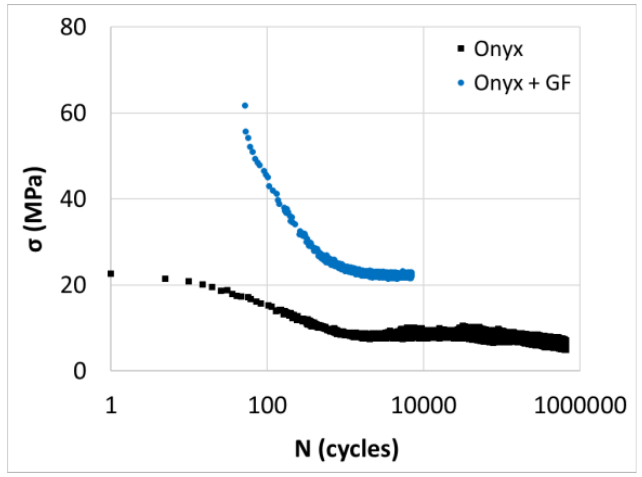
Figure 21. Relative stress (~Young’s modulus) trend within the fatigue test [24]. Variation in the amplitude of the applied loading results in self-heating for CF-PA6 and continuous glass fiber-reinforced CF-PA6 during the fatigue test. This phenomenon affects the viscosity of the polymer as a function of temperature. Figure 22 depicts the temperature rise during the fatigue test concerning the utilized frequency of 10 Hz. It was observed that the induced temperature of CF-PA6 increased up to about 60 ◦ C, which is in the glass transition zone. Consequently, the stiffness of the matrix agent (polymer) decreased based on the obtained loss factor evolution versus the temperature curve from the performed DMTA test, as shown in Figure